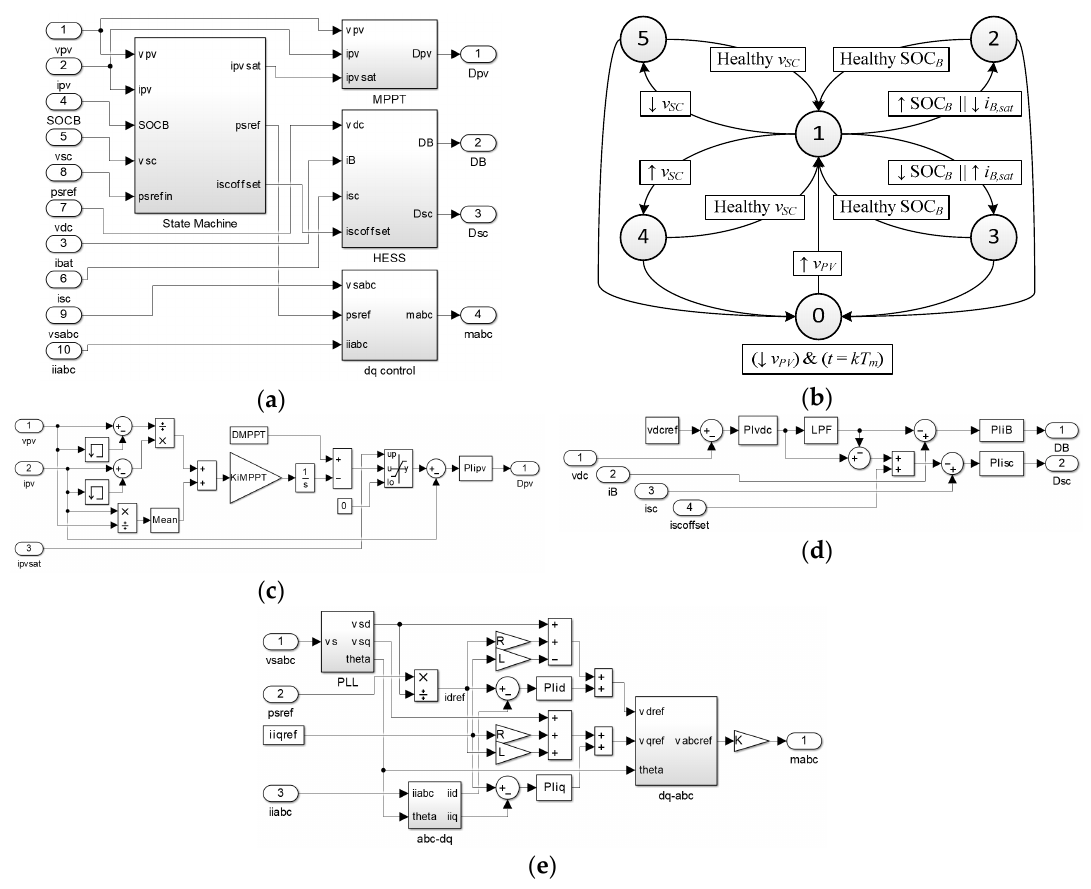
Figure 8. Control logic: ( a ) full scheme, ( b ) state machine, ( c ) MPPT, ( d ) HESS diagram and ( e ) dq diagram. ( e ) dq